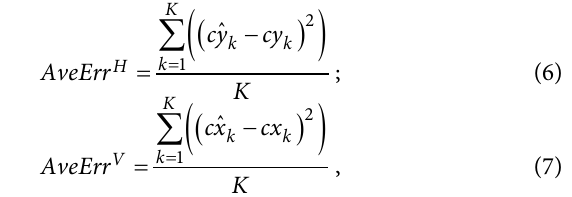
zontal polynomial curve fitting on the PCrC as shown in Figure 10. Curve fitting results are presented in Figure 10b and Figure 10c, where red lines represent fitting curves.